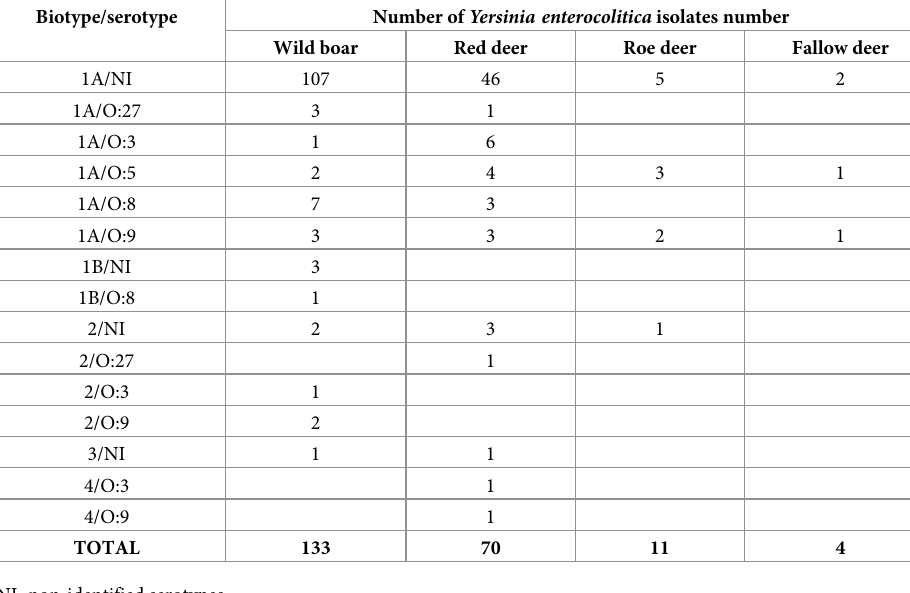
Table 2. Biotype and serotype characteristics of Yersinia enterocolitica isolates.